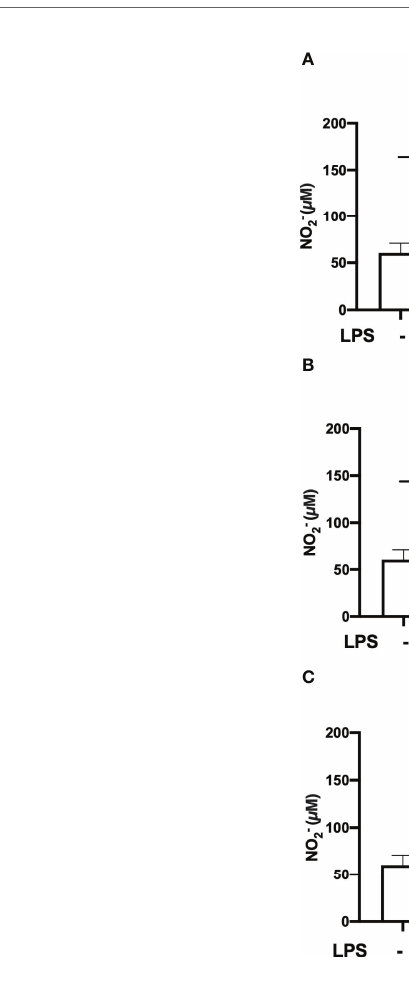
FIGURE 6 | NO − 2 production by BMDMs is triggered by EVs of F . pedrosoi and F. nubica obtained from RM, but not from MM conditions. MM MC- stands for minimum medium without muriform cells and MM MC+ for minimum medium in the presence of muriform cells. Evs (80 ng/mL of sterol content) from F. pedrosoi (A) , F. nubica (B) , and F. erecta (C) grown in RM, MM MC-, and MM MC+ were incubated with 1x10 6 BMDMs in the presence or absence of lipopolysaccharide (LPS, 500 ng/mL) for 24h following assessment of NO − 2 production detected by Griess microplate assay. For all plots, * indicates p < 0.05, ** indicates p < 0.01, **** indicates p < 0.0001 compared to negative and positive control according to one-way analysis of variance (ANOVA). The results presented in this work refer to a representative triplicate group experiment of at least two independent